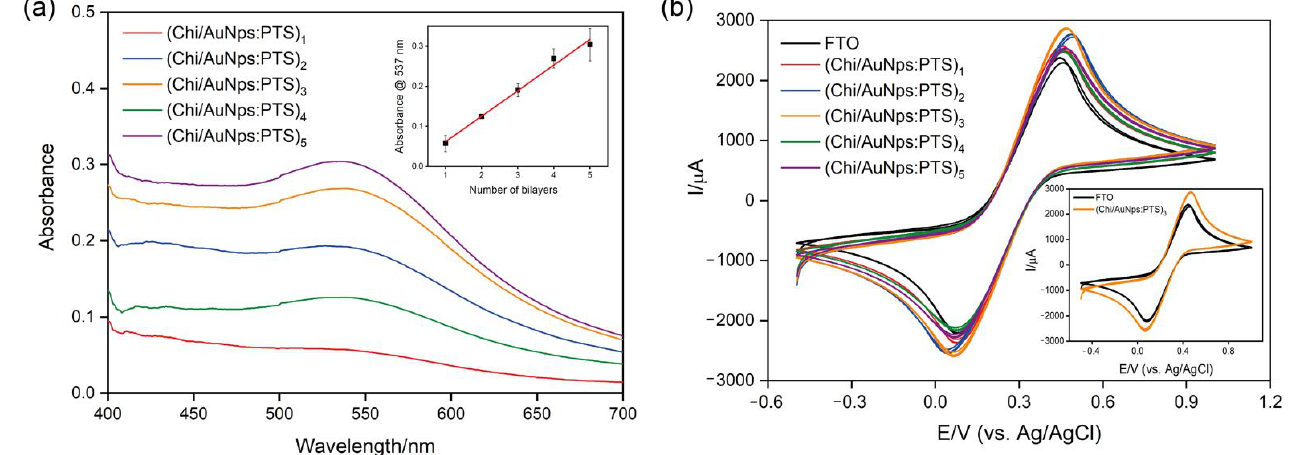
Figure 1. ( a ) UV – vis absorption spectra (from 400 to 700 nm) for LbL films ranging from 1 up to 5 bilayers of Chi/AuNPs:PTS. Inset shows the dependence of the absorbance with the number of deposited bilayers. ( b ) Cyclic voltammograms for FTO and FTO-(Chi/AuNPs:PTS) LbL films in 5 mmol L −1 [Fe (CN) 6 ] 3−/4− solution with 0.1 mol L −1 KCl. The inset highlights the comparison between the CVs obtained for bare FTO and FTO-(Chi/AuNPs:PTS) 3 bilayers.